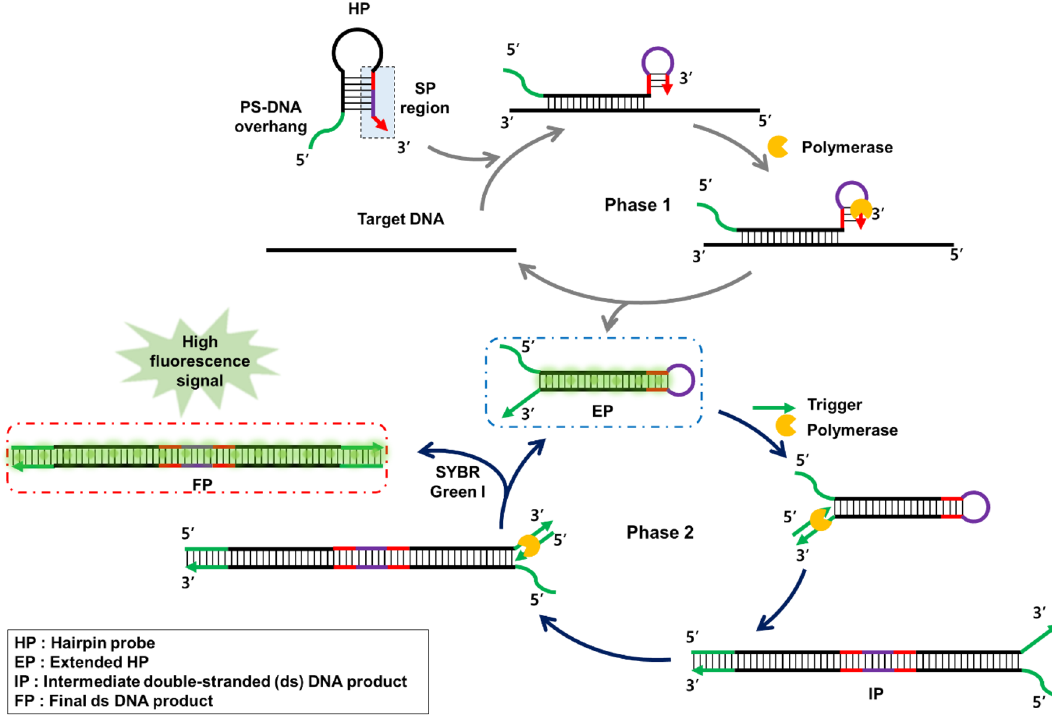
Figure 1. Schematic illustration of the phosphorothioated hairpin-assisted isothermal amplification (PHAmp) for detection of a target nucleic acid. This figure was created using PowerPoint Professional Plus 2016 (https:// www. micro soft. com/ ko- kr/ micro soft- 365/ power